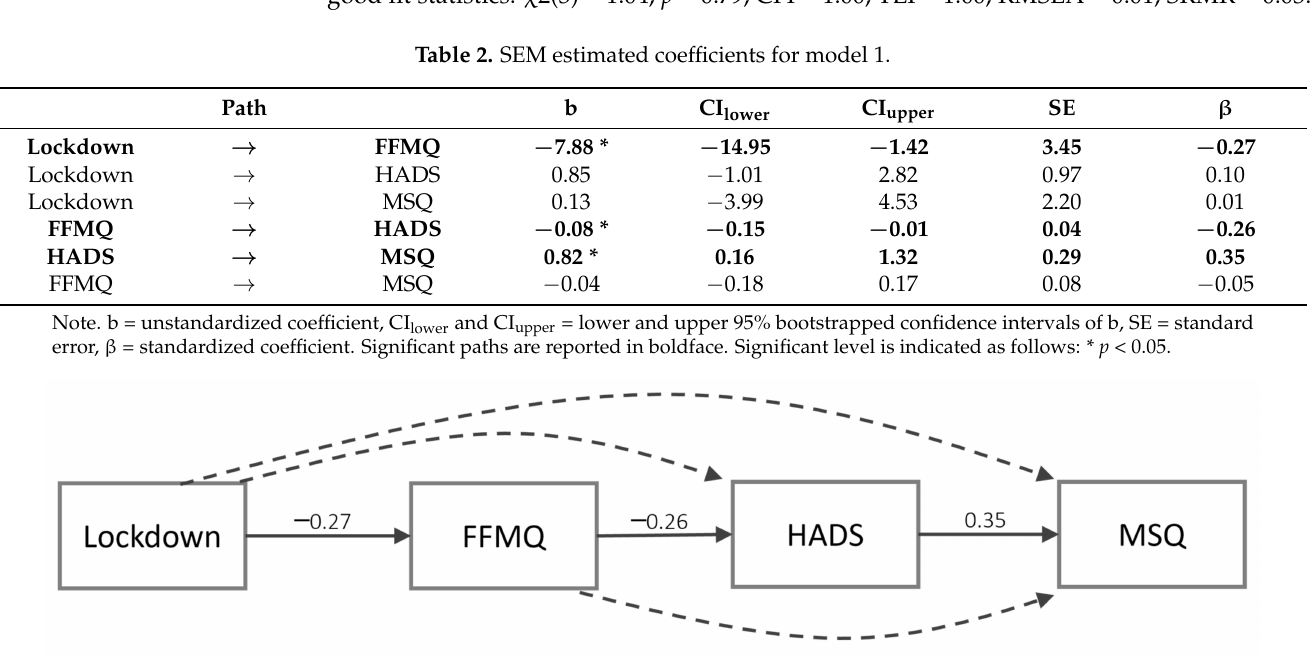
Figure 1. First model including only the total scores. Continuous arrows represent significant paths, while dotted arrows represent non-significant paths. Standardized coefficients are reported only for significant